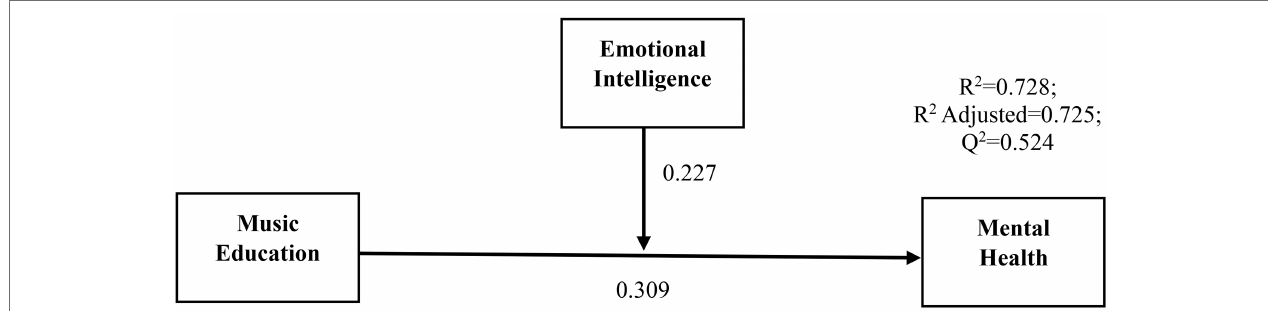
FIGURE 2 | Path analyses, coefficient of determination in the partial least squares (PLS)